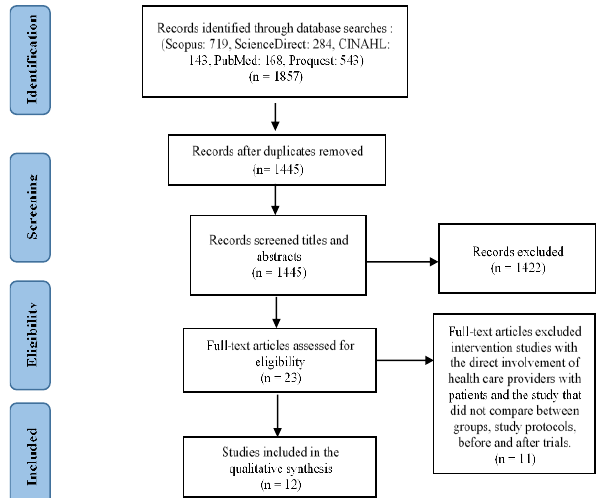
Figure 1: Flowchart of the study selection